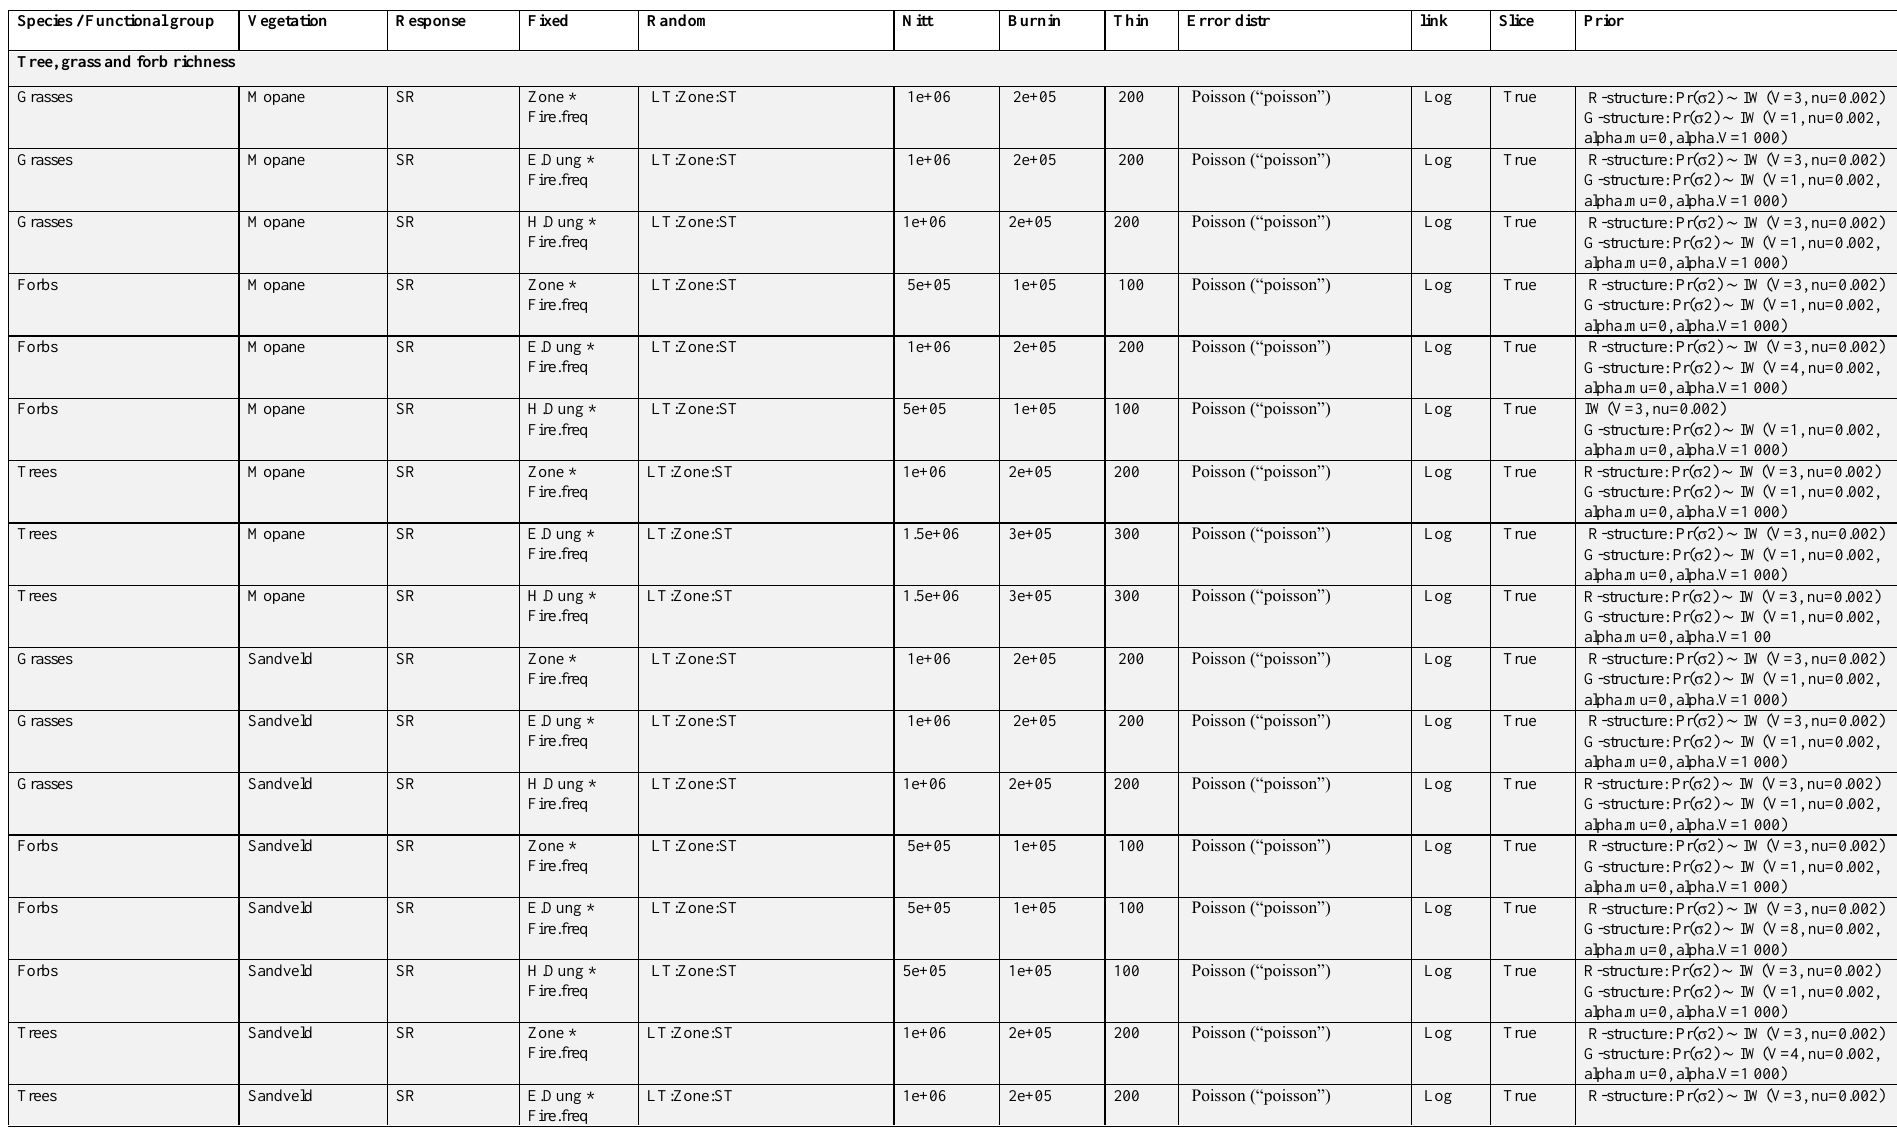
TABLE 1: Details of model specifications for the MCMCglmm analyses of tree, grass and forb richness, structural responses of various tree species and cover of various grass